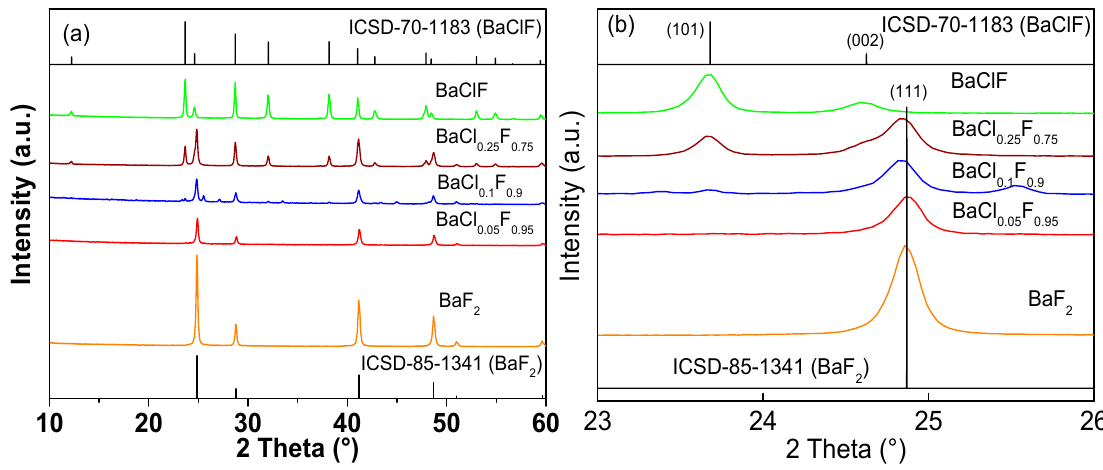
Figure 2. ( a ) XRD patterns of BaF 2 and barium chlorofluoride catalysts before reactions. ( b ) Highlighted XRD patterns with 2 θ between 23° and 26°.